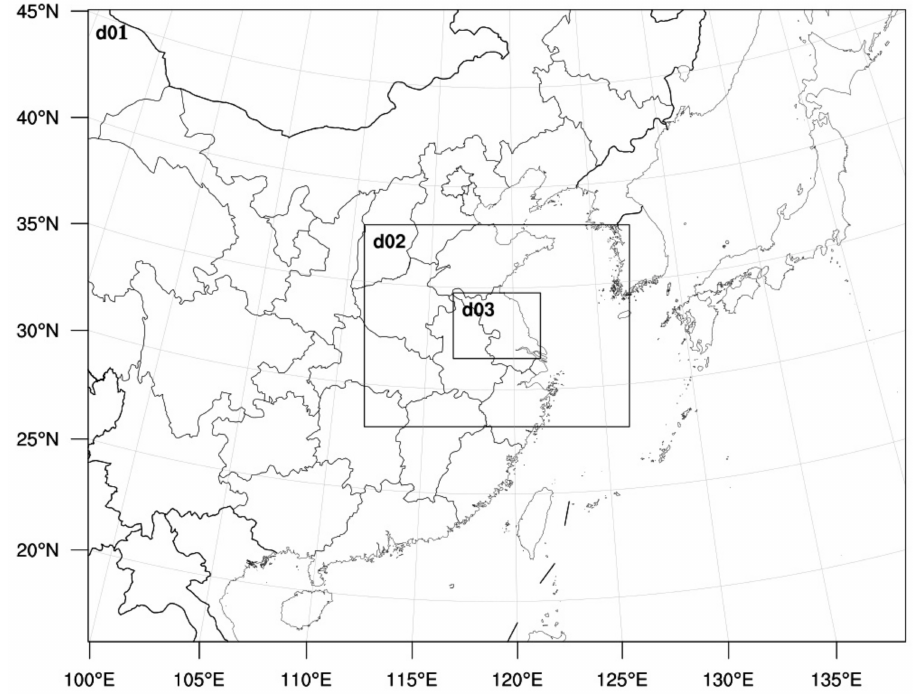
Figure 3. Three-layer nesting with horizontal resolutions of ( d01: Outermost layer ) 10 km, ( d02: Second layer ) 2 km, and ( d03: Innermost layer ) 0.4